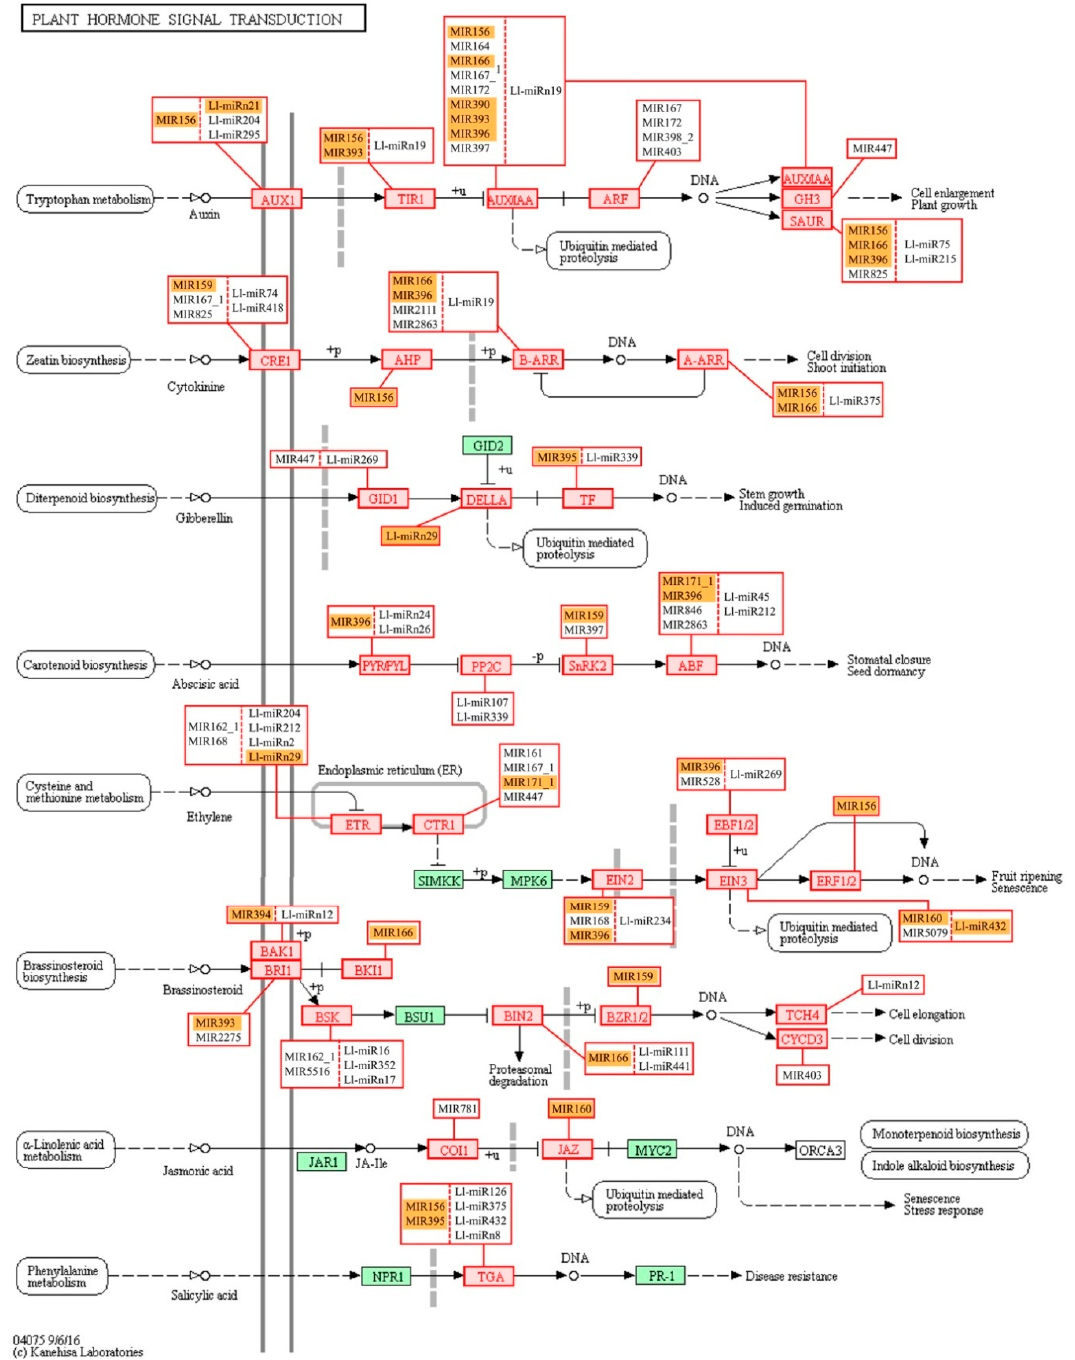
Figure 10. KEGG pathways related to plant hormone signal transduction targeted by known and novel miRNAs. Orange indicates DE miRNAs.